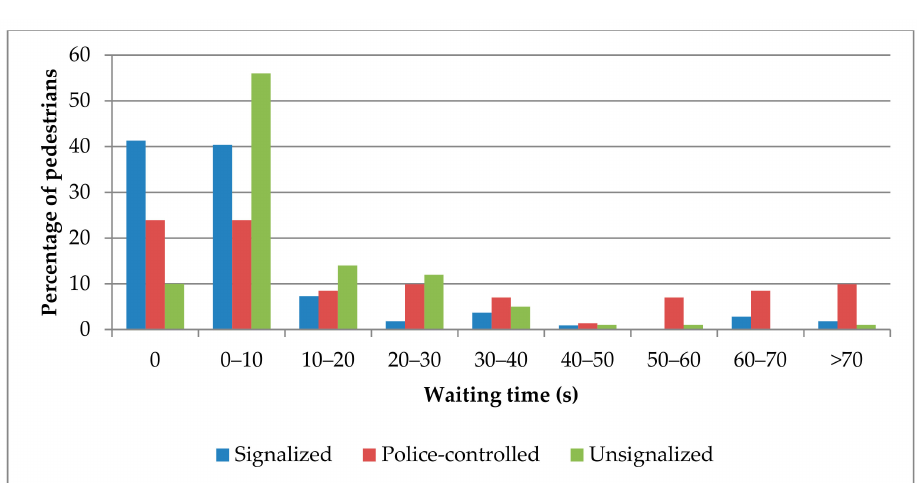
Figure 3. Waiting time of pedestrian by intersection control